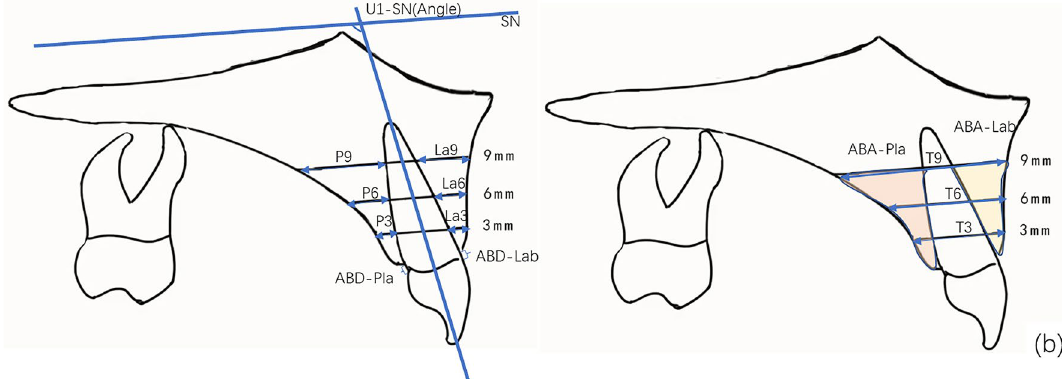
Figure 1. Schematic diagram of the CBCT measurement image, measurement mark points and measurement indicators. ( a ) CBCT reconstruction sagittal localization map ( b ) Schematic diagram of alveolar bone thickness, distance and area measurement. Along the long axis of the tooth, horizontal lines parallel to the SN plane were drawn at 3, 6 and 9 mm away from the root of the cementoenamel junction (CEJ), which was designated as crestal (La3 and P3), mid-root (La6 and P6) and apical third (La9 and P9); labial and palatal alveolar bone area (ABA-Lab and ABA-Pla); labial and palatal alveolar bone distance (ABD-Lab and ABD-Pla), defined as the distance from the CEJ to the alveolar ridge